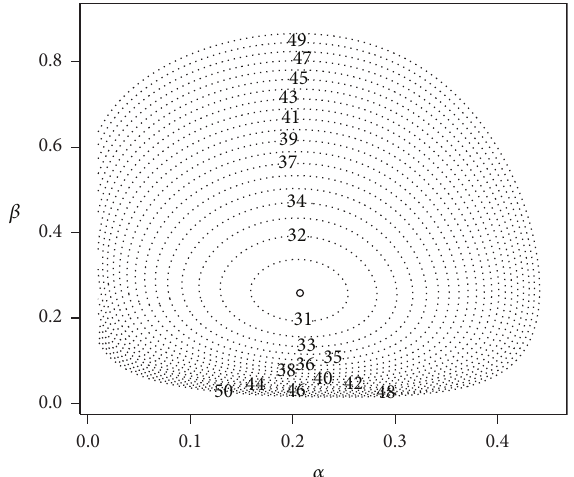
Figure 2: Likelihood contour plot with respect to parameters for real data